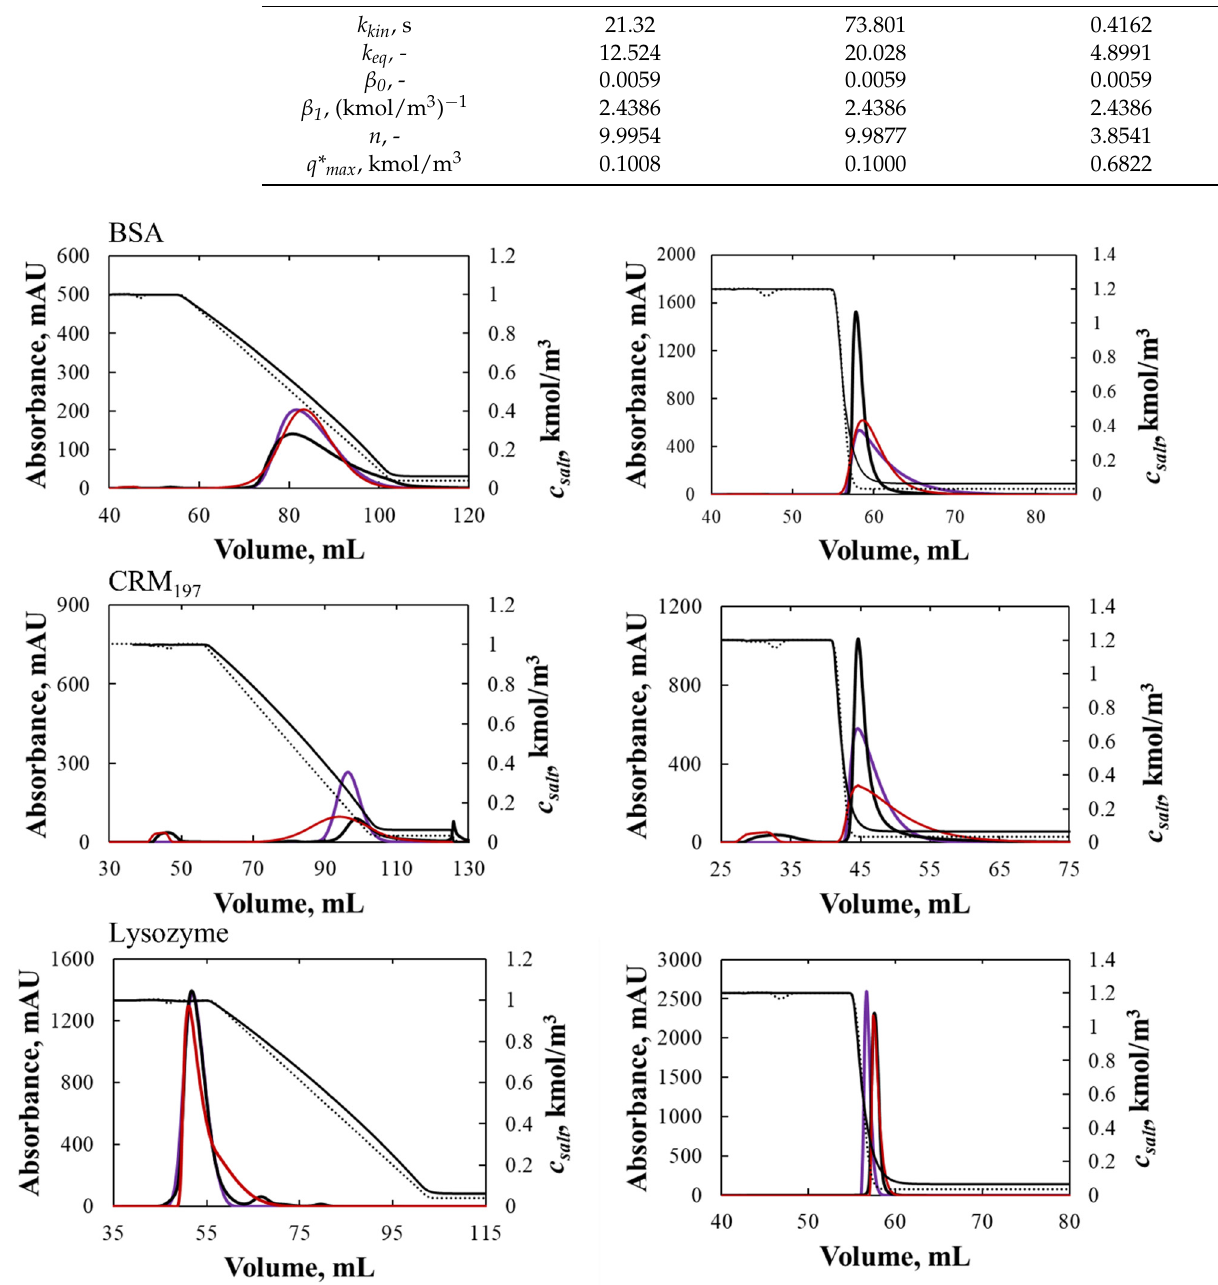
Figure 8. Comparison between experimental and simulated bind-elute test chromatograms of BSA, CRM 197, and Lysozyme after the model parameter estimation using the DSPX code. On the left the gradient elution and on the right the isocratic elution. The black, violet and red lines are, respectively, relative to the experimental peak, the peak simulated with the model of Mollerup et al. and with the model of Wang et al. The thinner black line is the experimental normalized conductivity while the dashed line is the simulated outlet salt concentration. Table 8. Parameter values for Mollerup et al. model estimated by DSPX.